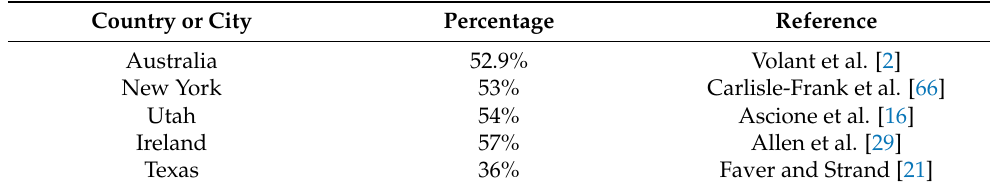
Figure 2. Association among lack of empathy, habituation to domestic violence, and animal cruelty. aCC: anterior cingulate cortex; AMYG: amygdala; AVP: vasopressin; dlPFC: dorsolateral prefrontal cortex; GLU: glutamate; IFG: inferior frontal gyrus; In: insula; mPFC: medial prefrontal cortex; NT: neurotransmitter; OXT: oxytocin; P4: progesterone; PRL: prolactin; STR: striatum; TPJ: temporopari- etal junction; vmPFC: ventromedial prefrontal cortex; VTA: ventral tegmental area. Table 1. Percentage of domestic violence victims who have witnessed animal abuse in five